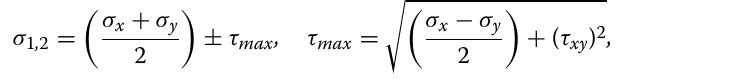
taken from [59] and [60] respectively, using a refined numerical model. With the stresses at point A and B calculated